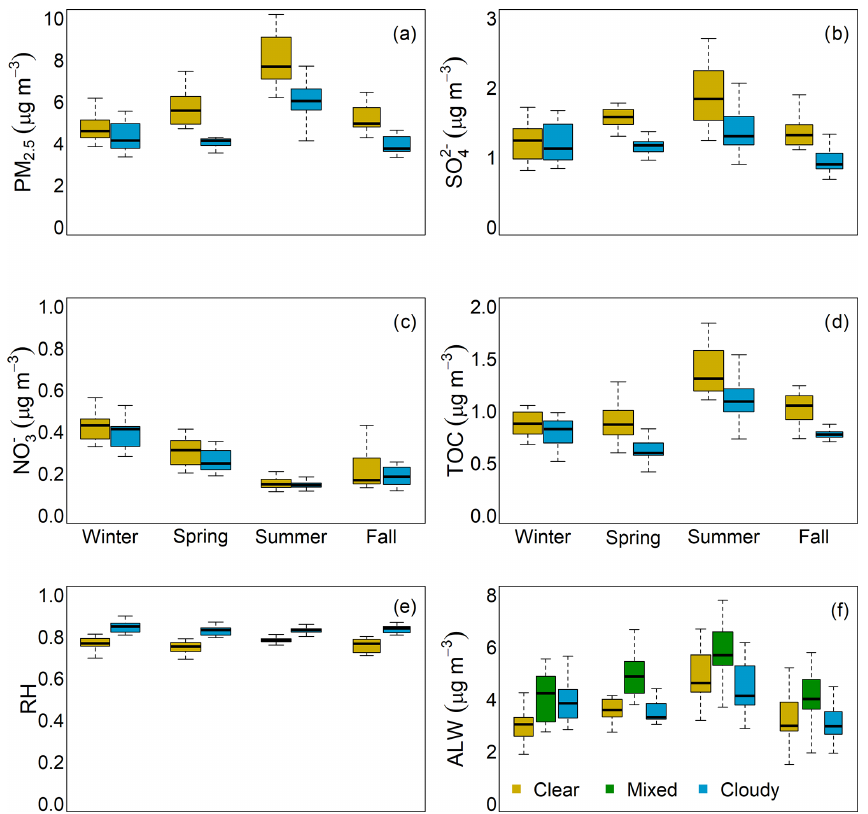
Figure 3. Distributions of (a) PM 2 . 5 , (b) SO 4 , (c) NO 3 , (d) TOC, (e) RH, and (f) ALW mass concentrations during all seasons in the eastern US. Yellow box plots indicate clear-sky times, and blue box plots indicate cloudy times. In (b) , the green box plots represent the mixed ALW